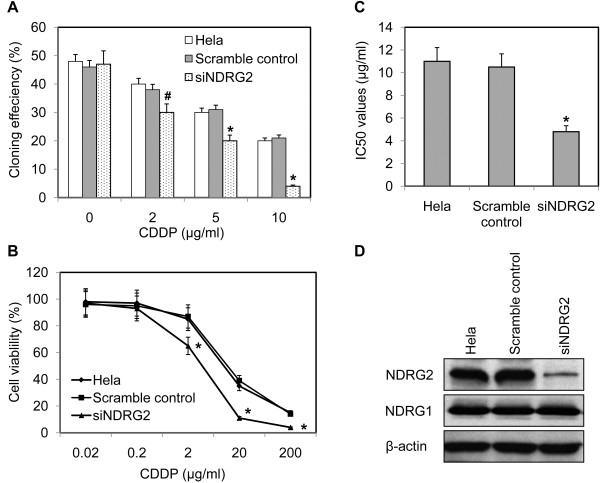
Down-regulation of NDRG2 sensitized Hela cells to cisplatin. Hela cells were transfected with pSilencer3.1 constructs expressing NDRG2-specific siRNA (siNDRG2) or scramble control. The G418-resistant mix clones were selected for further assays. A. The colony-formation ability of Hela cells and their variants was evaluated in the presence or absence of cisplatin (CDDP). B. Cell viability was evaluated by MTT assay as described in “Materials and Methods” and plotted against CDDP concentration. C. The IC50 values were determined according to the plot. * p < 0.01 vs Hela and scramble control. D. Down-regulation of NDRG2 in stable clones was displayed by Western blot with β-actin as loading control. Shown are representative of 3 independent experiments. * p < 0.01 vs Hela and scramble control. # p < 0.05 vs Hela and scramble control.